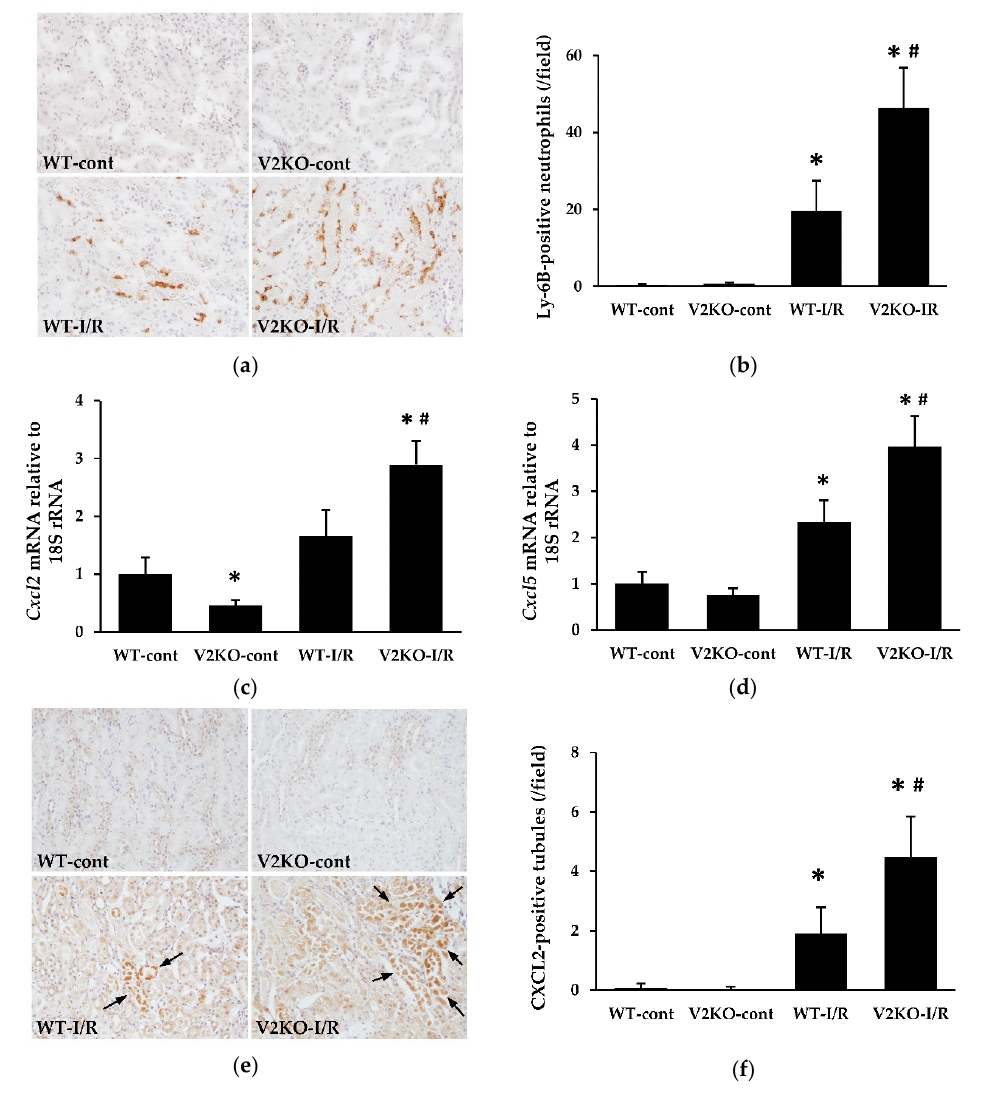
Figure 3. VASH2 deficiency accelerated neutrophil infiltration in I/R-induced kidney injury. ( a ) Immunohistochemical images of Ly-6B.2, a marker for neutrophils, in the kidney (original magnification, ×200). ( b ) The number of Ly-6B.2-positive cells was higher in V2KO-I/R mice than WT-I/R mice; ( c ) Cxcl2 and ( d ) Cxcl5 mRNA expression in the kidney. Data were normalized with the expression of 18S rRNA. ( e ) Immunohistochemical images of CXCL2 (original magnification, ×200). CXCL2-positive tubules are indicated by arrows. (f) The number of CXCL2-positive tubules was higher in V2KO-I/R mice than WT-I/R mice. n = 6 for each group. * p < 0.01 vs. WT-cont, # p < 0.05 vs. WT-I/R. Each column shows the mean ± SD.